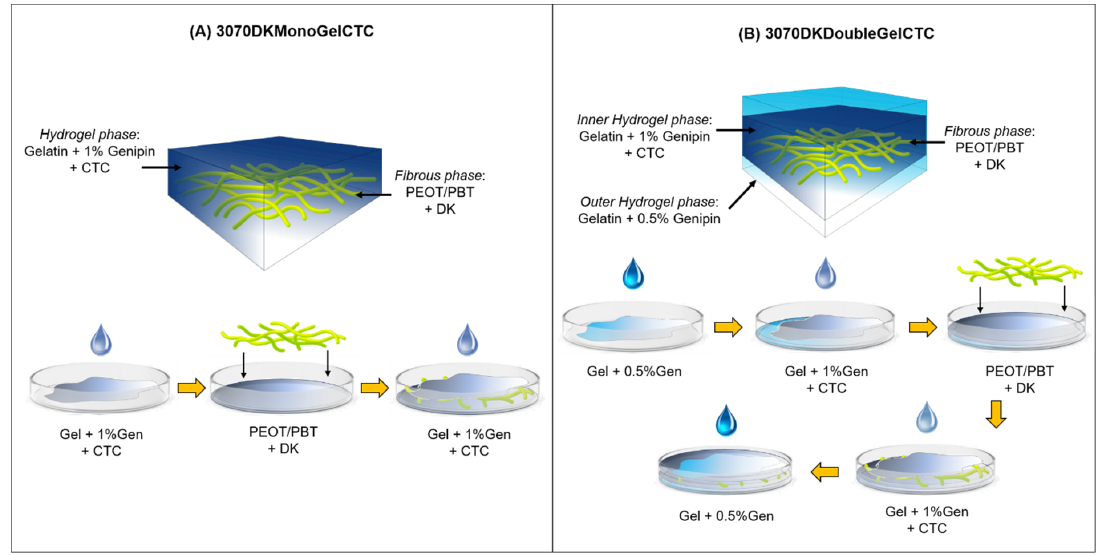
Figure 1. Schematic illustration of the final structure and of the procedure for the fabrication of 3070DKMonoGelCTC ( A ) and 3070DKDoubleGelCTC ( B ). 3070DKMonoGelCTC ( A ) and 3070DKDoubleGelCTC ( B